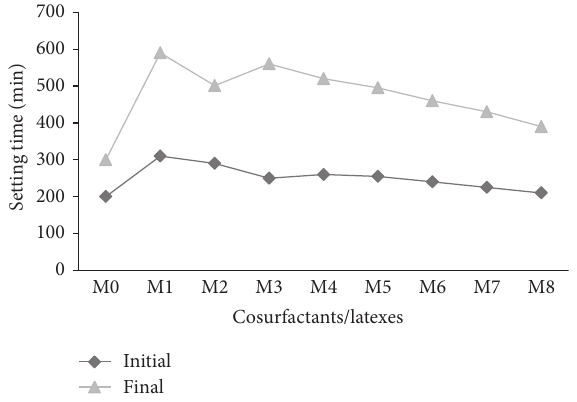
Figure 4: The effect of cosurfactants and copolymer latexes on the setting time of mortar.